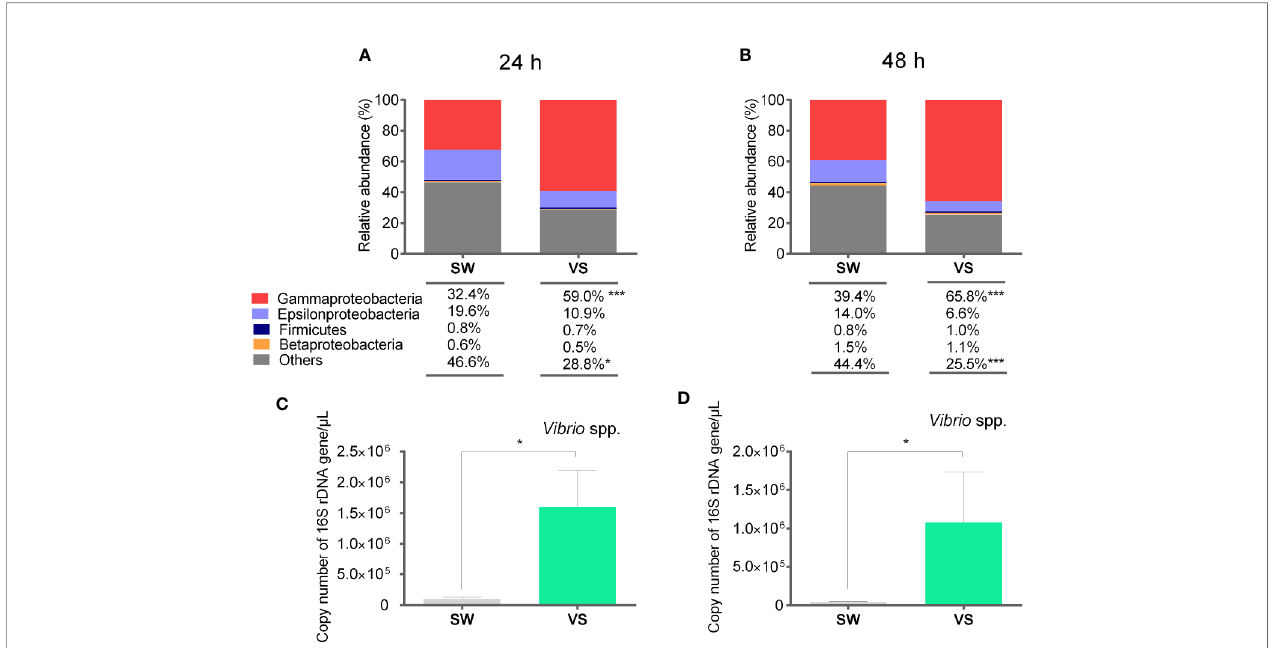
FIGURE 4 | Relative abundances of target bacterial groups present in scallop hemolymph after immune stimulation determined by qPCR and absolute quanti fi cation. Stack bar graphs indicate the average relative abundance of target bacterial groups in Vibrio-injected scallops (VS) and seawater-injected scallops (SW) at 24 h (A) and 48 h (B) after challenge. Number of total copies of speci fi c bacterial 16S rDNA gene for Vibrio spp. at 24 h (C) and 48 h (D) after challenge are represented as the mean ± SE, and asterisks indicate signi fi cant differences compared to SW-injected scallops (*** P < 0.005; * P <